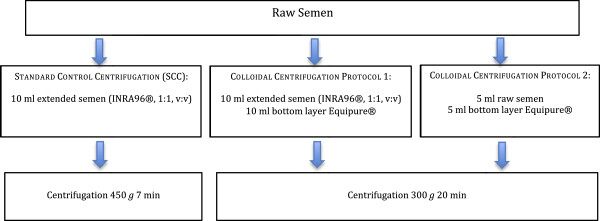
Semen centrifugation protocols.